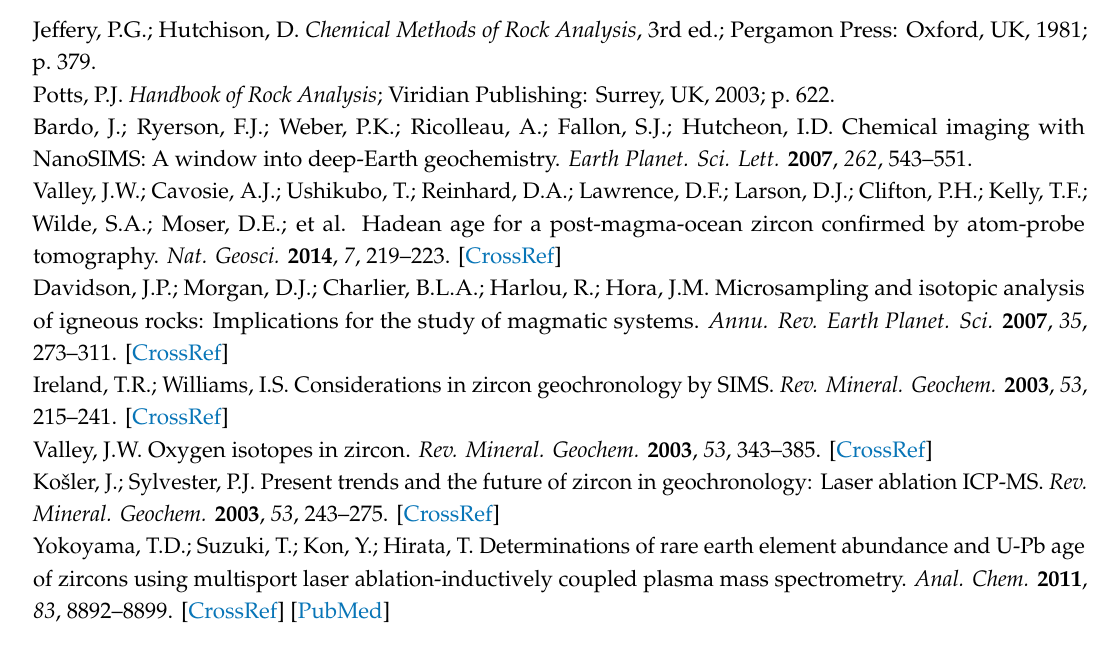
Figure S1: Plot of 206 Pb / 238 U dates and U concentrations for the SHRIMP spots of the LKZ-1 zircon. Figure S2: 176 Hf / 177 Hf vs. 176 Lu / 177 Hf plot for the LKZ-1 zircon. Table S1: SHRIMP U–Th–Pb results for the Plešovice zircon. Table S2: HR-SIMS (Cameca 1280) oxygen isotope data for the analyzed zircons. Table S3: LA-MC-ICPMS Lu–Yb–Hf isotopic results for the 91500 zircon. Table S4: LA-ICPMS results for the 91500 and LKZ-1